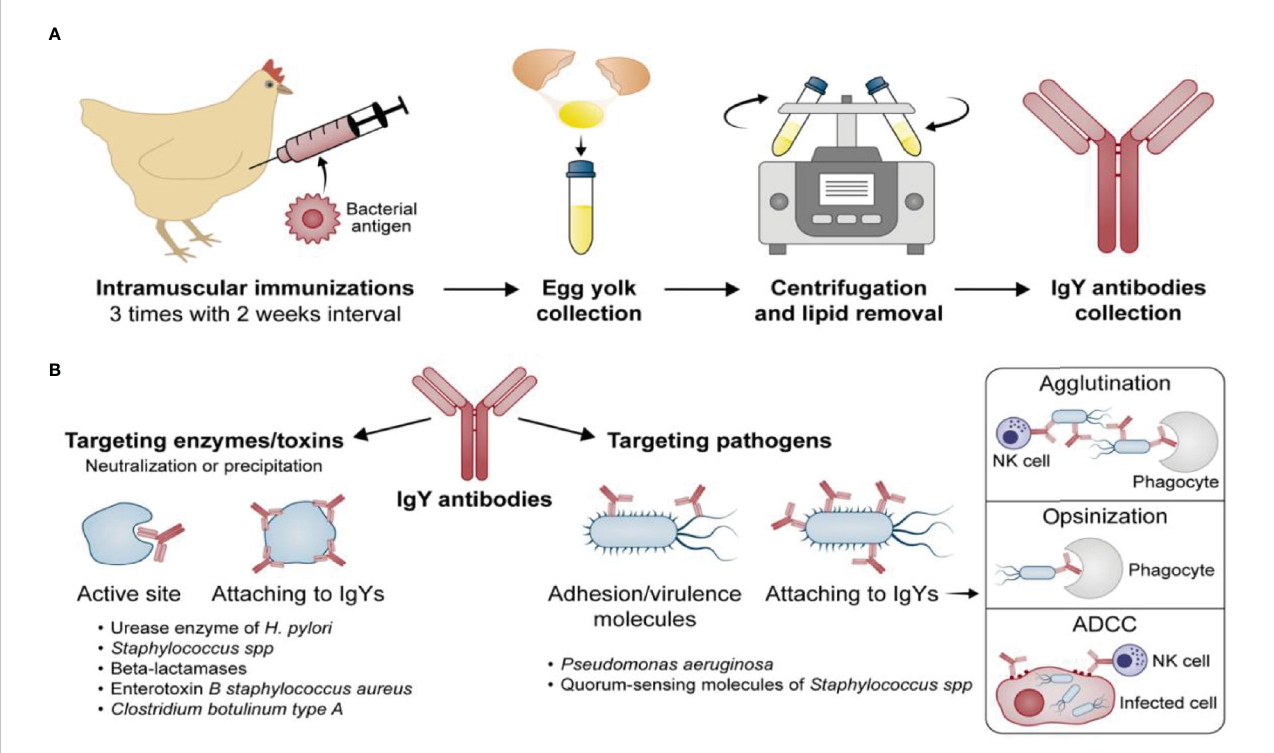
FIGURE 1 Development of the IgY antibodies (A) and their potential mechanisms of action (B)